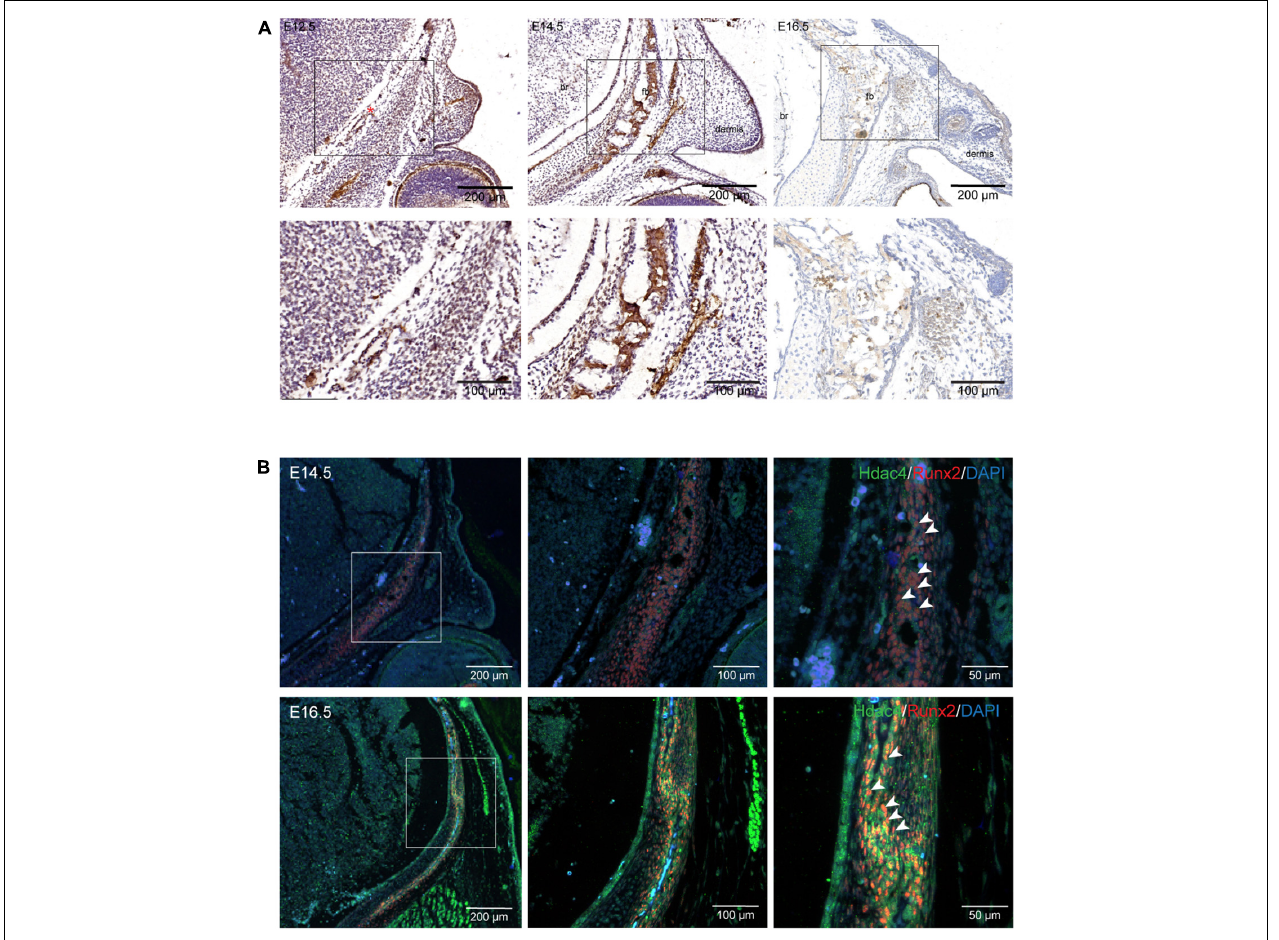
FIGURE 1 | Hdac4 expression during frontal bone development. (A) Immunohistochemical staining of coronal sections of the embryonic mouse head at E12.5, E14.5, and E16.5. At E12.5, HDAC4 expression was not evident in condensed mesenchymal cells in the presumptive frontal primordium (red asterisk). HDAC4 expression was detected in the frontal bone at E14.5 and E16.5. (B) Immunofluorescence staining of coronal sections of the embryonic mouse head at E14.5 and E16.5. HDAC4 expression largely overlapped with that of Runx2 (white arrowhead). Br, brain; fb, frontal